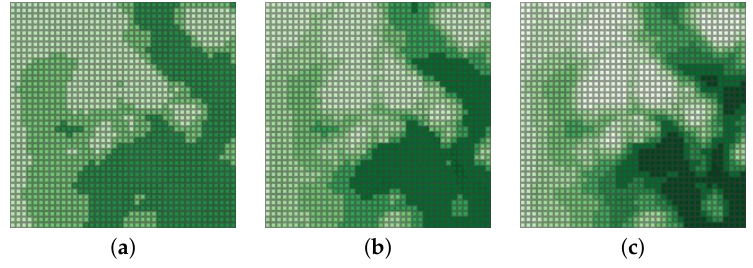
Figure 5. Height map generated using ( a ) 4 classes, ( b ) 6 classes and ( c ) 9